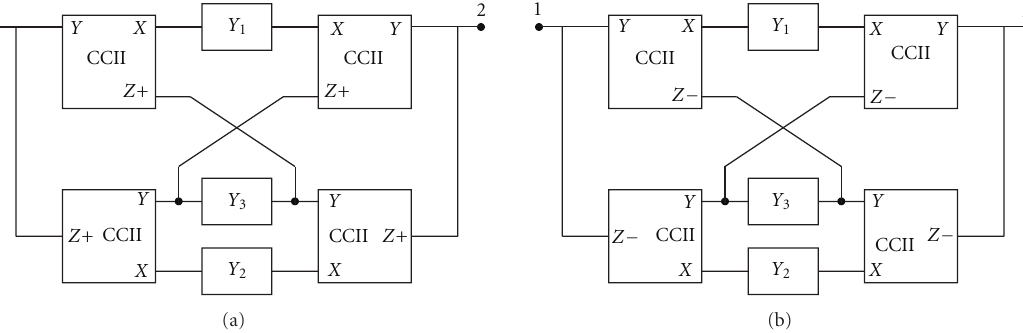
Figure 4: (a) Floating circuit 1 suitable for L realization [15]. (b) Floating circuit 2 suitable for L realization [15,